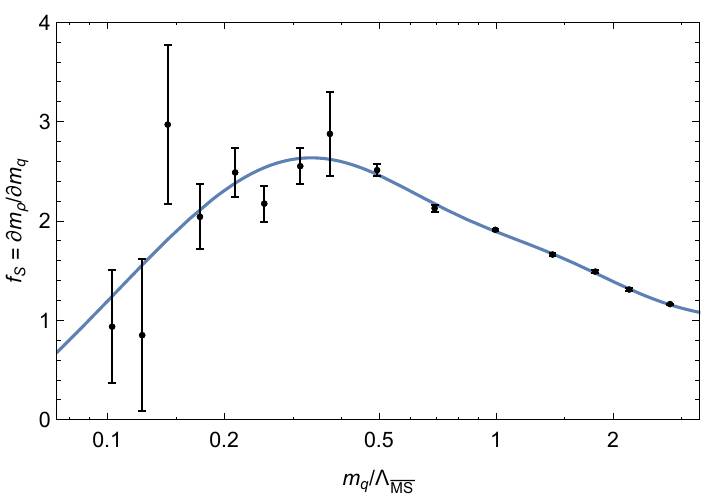
Figure 5 . Scalar form factor f S entering into the Higgs-DM coupling, obtained from (cid:12)nite di(cid:11)er- ences (points) and from an analytic (cid:12)t (solid curve). The analytic (cid:12)t is m (cid:26) = (cid:3) where F ( x ) = (2 : 12+0 : 87 x +10 : 60 x 2 ) e (cid:0) 3 : 94 x +(4 : 10+1 : 00 x )(1 (cid:0) e (cid:0) 1 : 42 x ) and has a (cid:31) 2 = dof (cid:25) 1 :